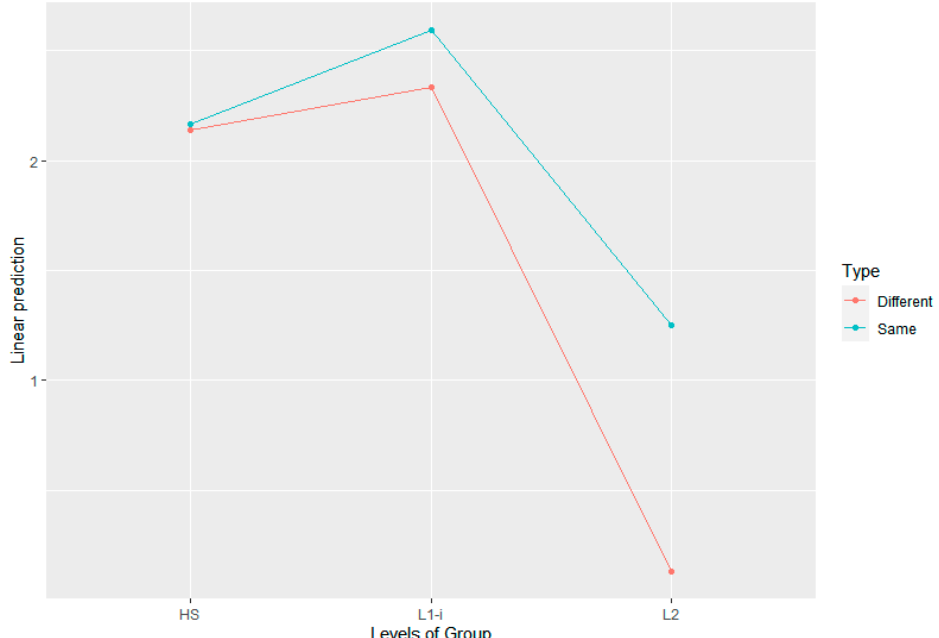
Figure 5. Linear prediction of the interaction effect between group and type. Y-axis represents the estimated means (coefficients) for each group in the pairwise post-hoc analysis of the mixed-effects logistic regression model.